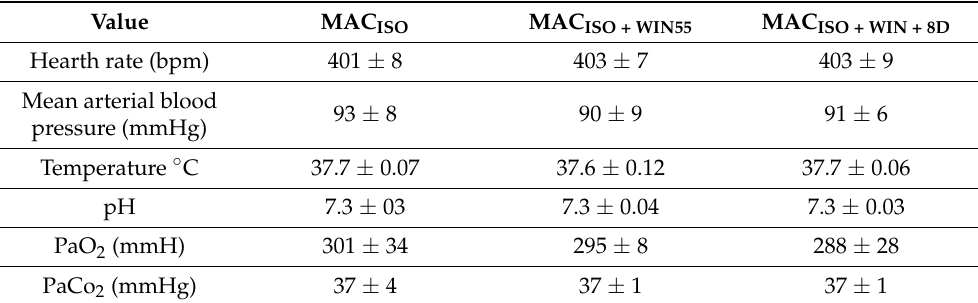
Table 1. MAC of Isoflurane in rats chronically treated with the synthetic cannabinoid WIN 55,212-2. Group MAC% SD MAC ISO 1.32 0.06 - 1.27–1.37 MAC ISO + WIN55 1.69 * 0.09 28% <0.0001 MAC ISO + WIN + 8D 1.67 *